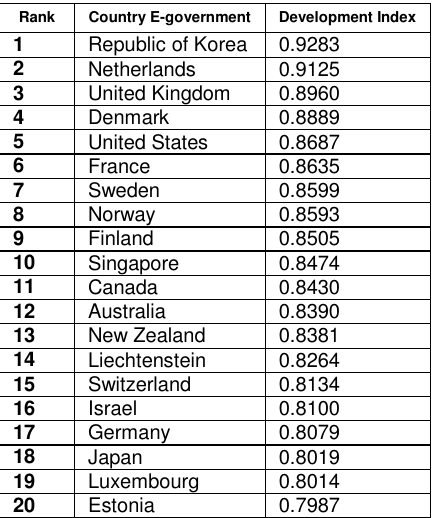
Table 1: World eGovernment Development Leaders as per UN E-Government Survey